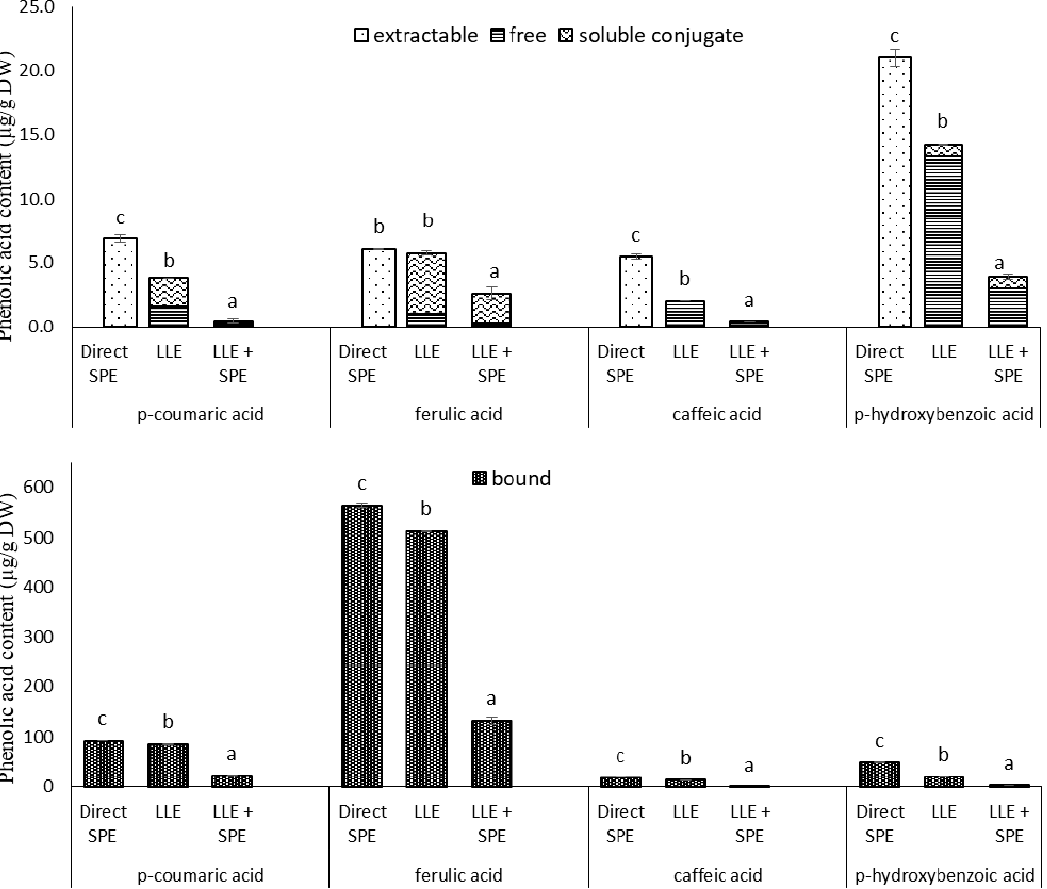
Figure 4. Individual phenolic acid contents from the extractions of the germinated spelt ( Triticum spelta ) seeds, as the extractable and bound phenolics from direct solid-phase extraction (SPE), and for the free, soluble conjugate and bound phenolics from the liquid–liquid extraction without (LLE) and with SPE (LLE + SPE) purification. Data are means ± SD. Different letters within the same phenolic acid as extractable and (free + soluble conjugate) or bound indicate significant differences ( p < 0.05; Duncan’s multiple range tests).